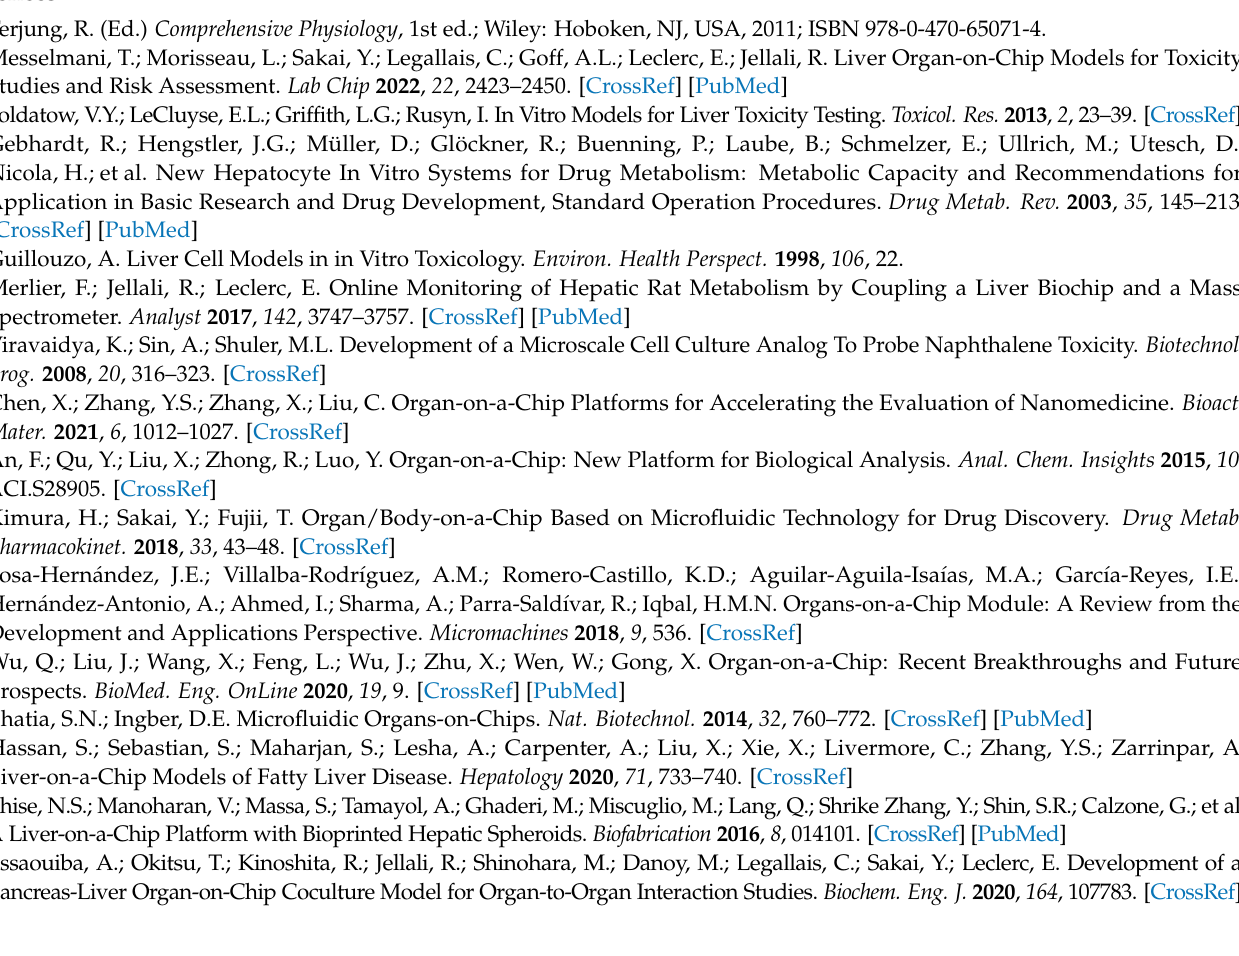
Copolymers; Figure S2: Schematics of the setup used for flow and pressure measurements; Figure S3: blue) and phalloidin (F-actin, green); scale bar 200 µ